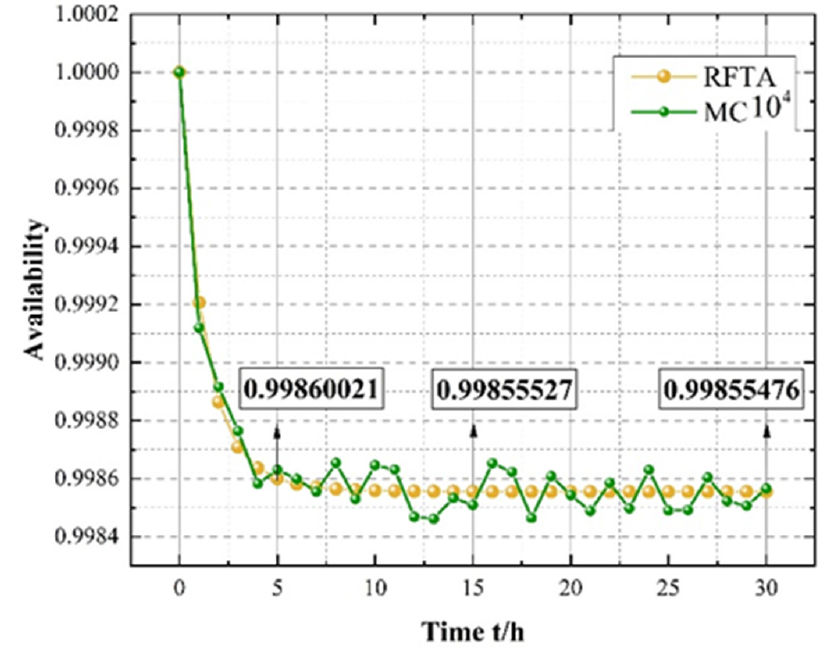
Figure 13. A comparison to the Monte Carlo algorithm.